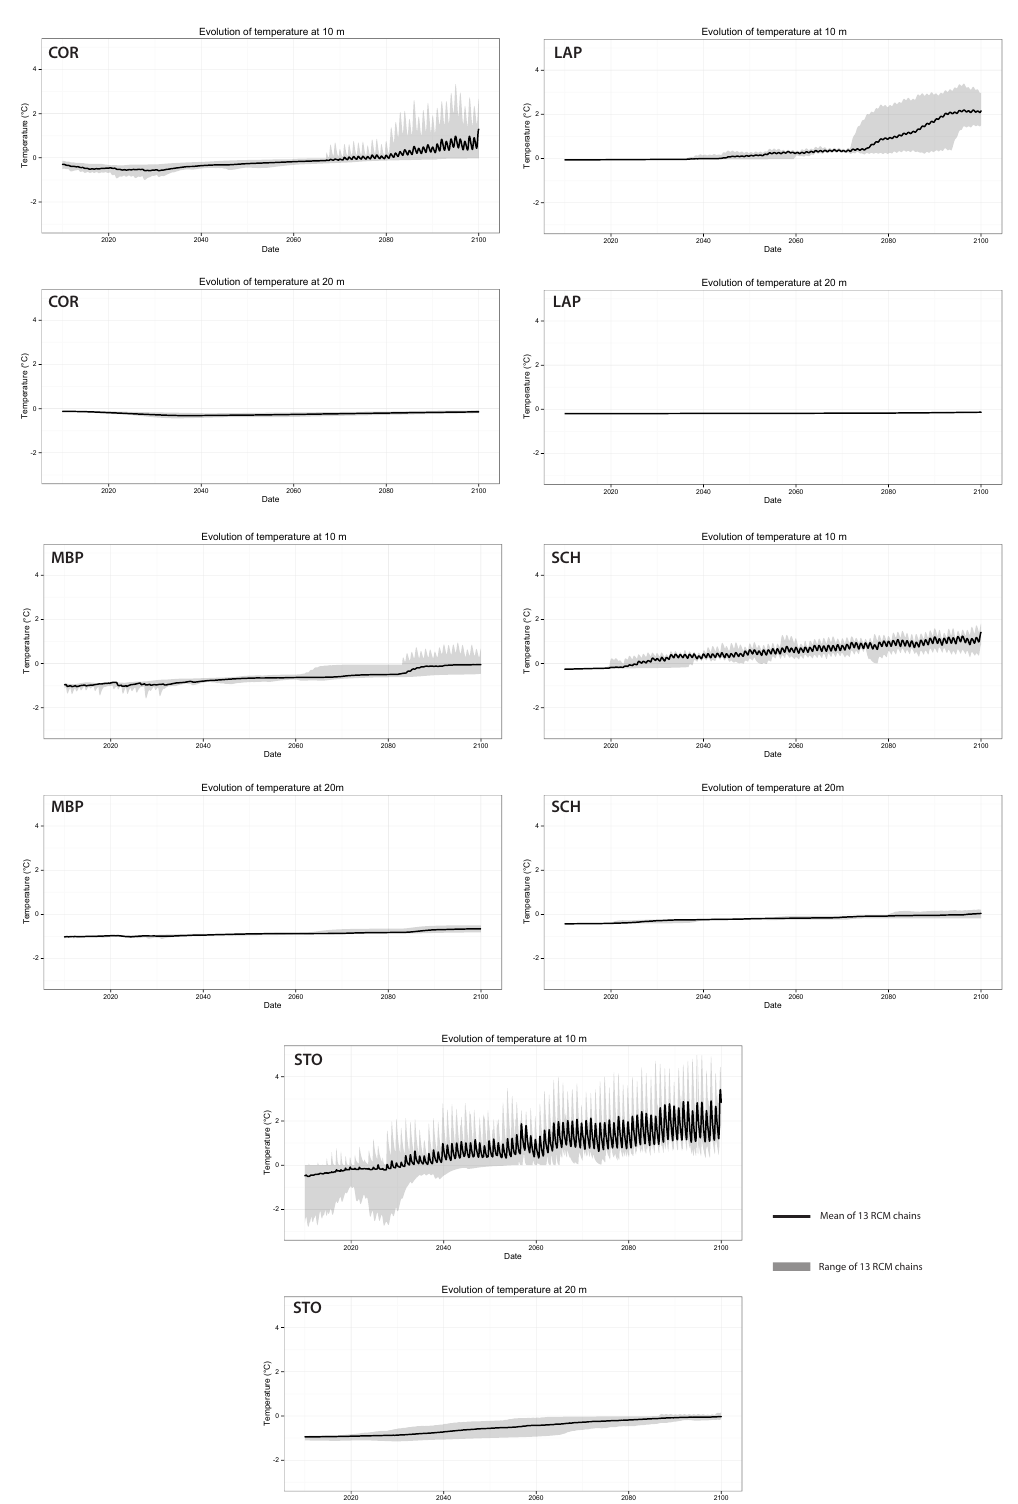
Figure 7. Long-term evolution of ground temperatures at 10 and 20m as simulated by the CoupModel for the different sites. The black lines represent the median scenario and the grey zone the range of the 13 GCM/RCM